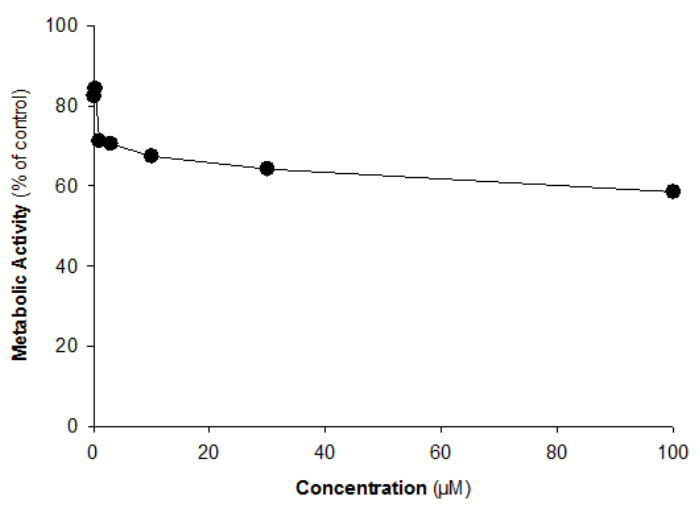
Figure 2. The inhibitory effects of kinsenoside on CYP2A6 enzyme activity in c-DNA expressed CYP2A6 supersomes. CYP2A6